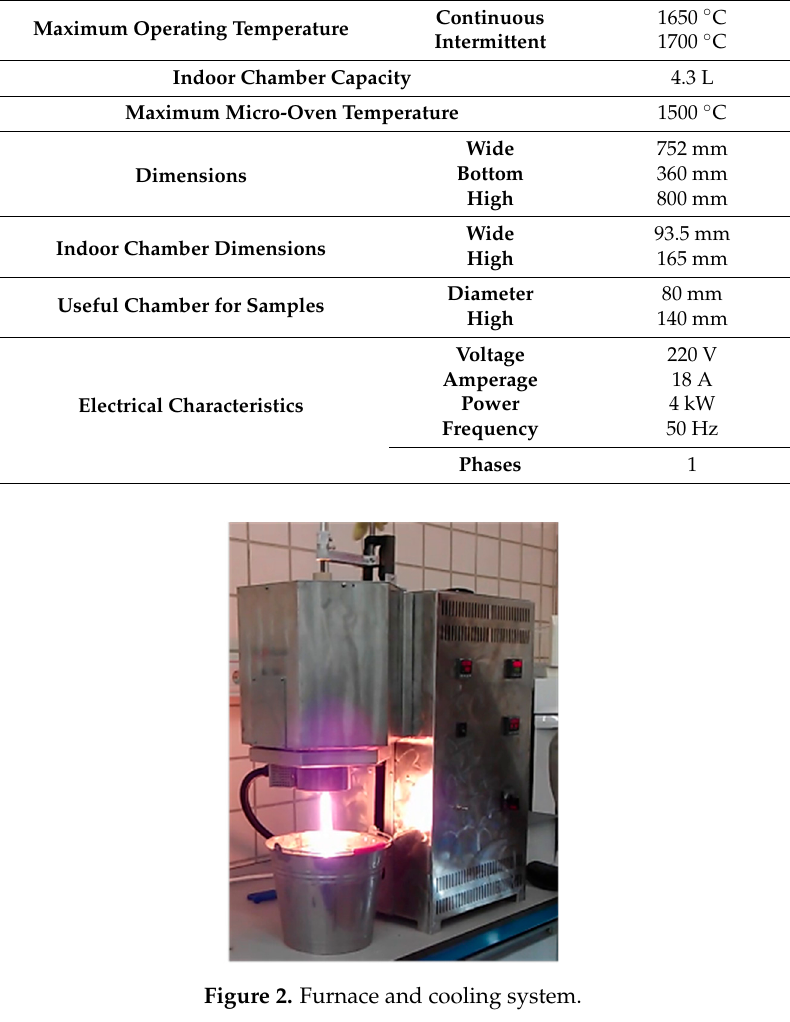
Table 2. Characteristics of the furnace.